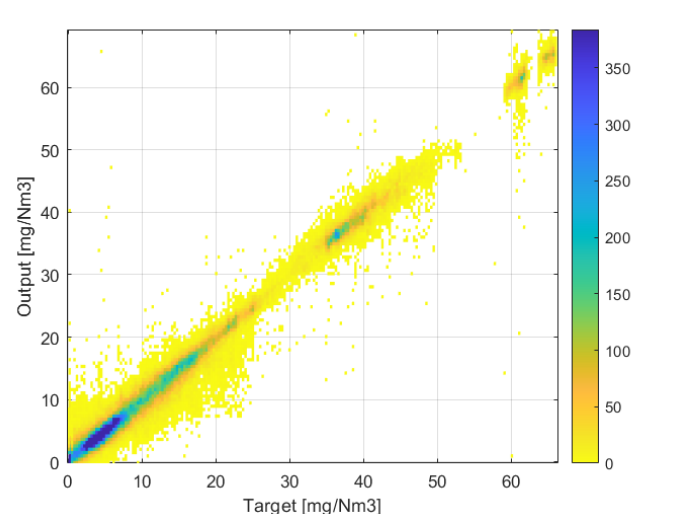
Figure 8. Regression plot of the output vs. the target for the prediction of the SO 2 concentration at the absorber outlet, with the data dispersion highlighted.